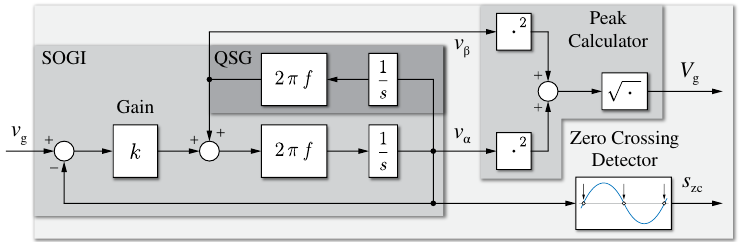
Figure 6. Block diagram of the adopted grid synchronization